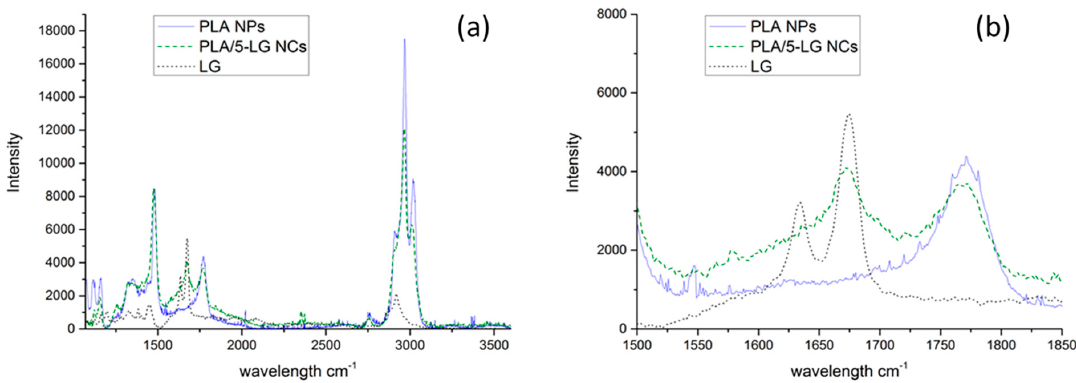
Figure 3. Raman spectra of PLA NPs ( blue line), PLA/5-LG NCs ( green dashed line) and LG oil ( black dots) ( a ) whole spectrum and ( b ) zoomed spectrum.